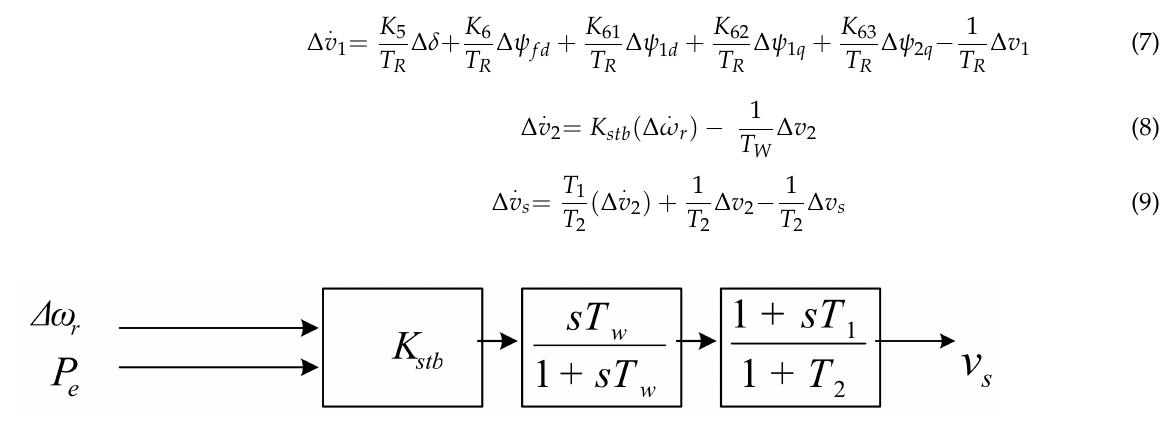
Figure 2. Block diagram of the